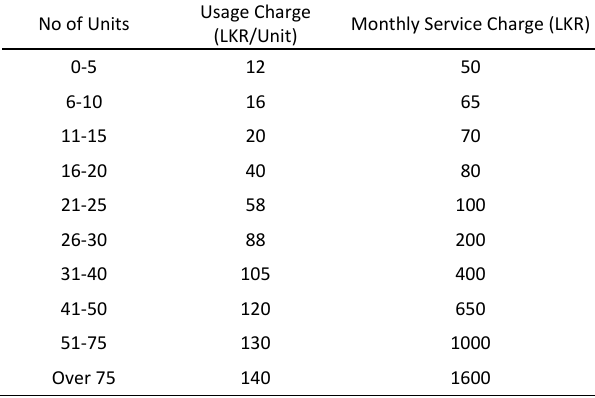
Table 8: Cost of water per cubic meter